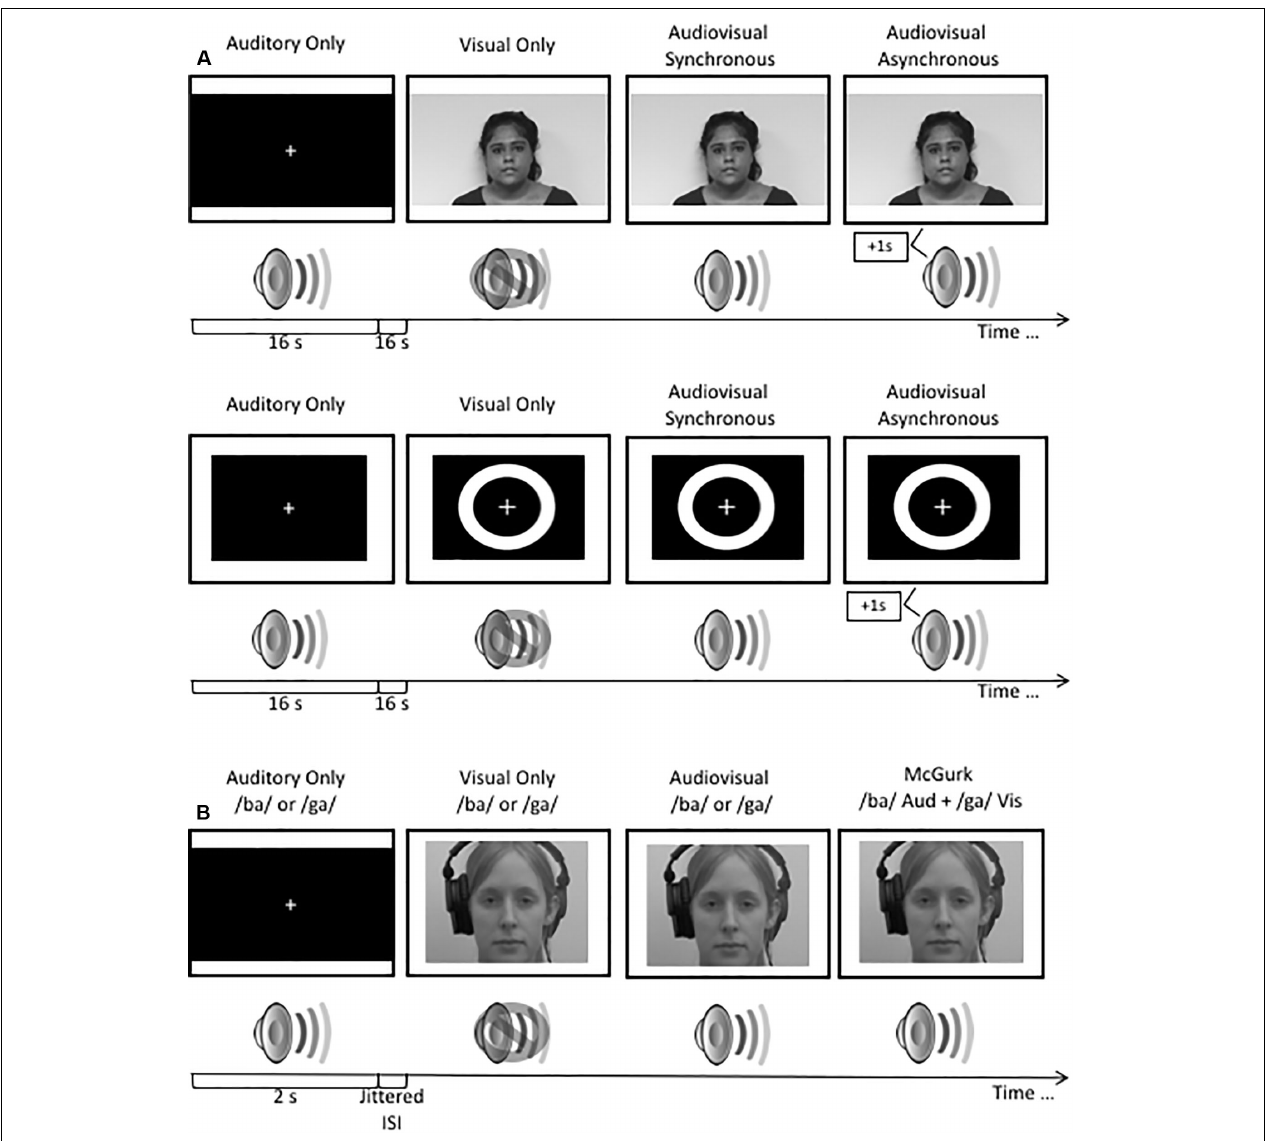
FIGURE 1 | (A) A schematic illustration of the stimuli used in the audiovisual blocked design study. (B) A schematic illustration of the presentation of stimuli used in the rapid event related design study. Stimuli used in the rapid event related design study have been previously published (see Quinto et al., 2010; Stevenson et al., 2012; Moro and Steeves, 2018a). All visual stimuli were presented to participants in